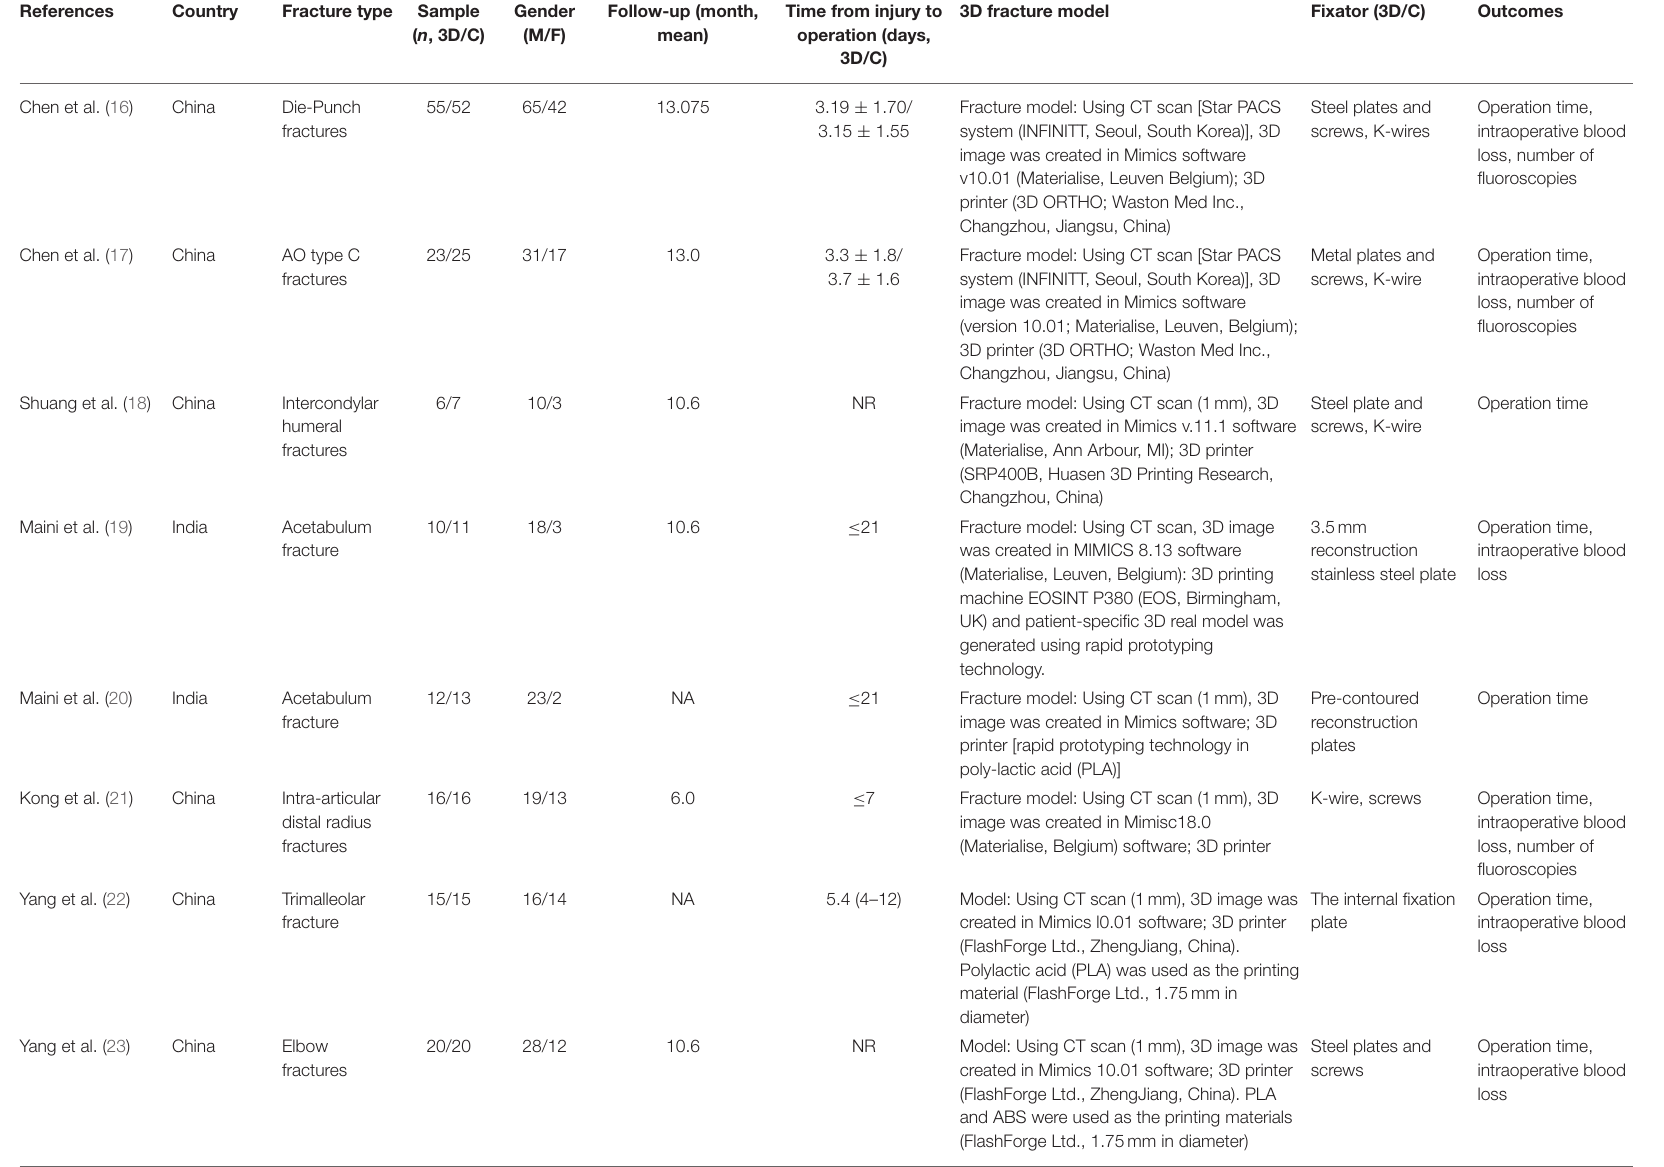
TABLE 1 | Basic characteristics of all the RCTs included in this